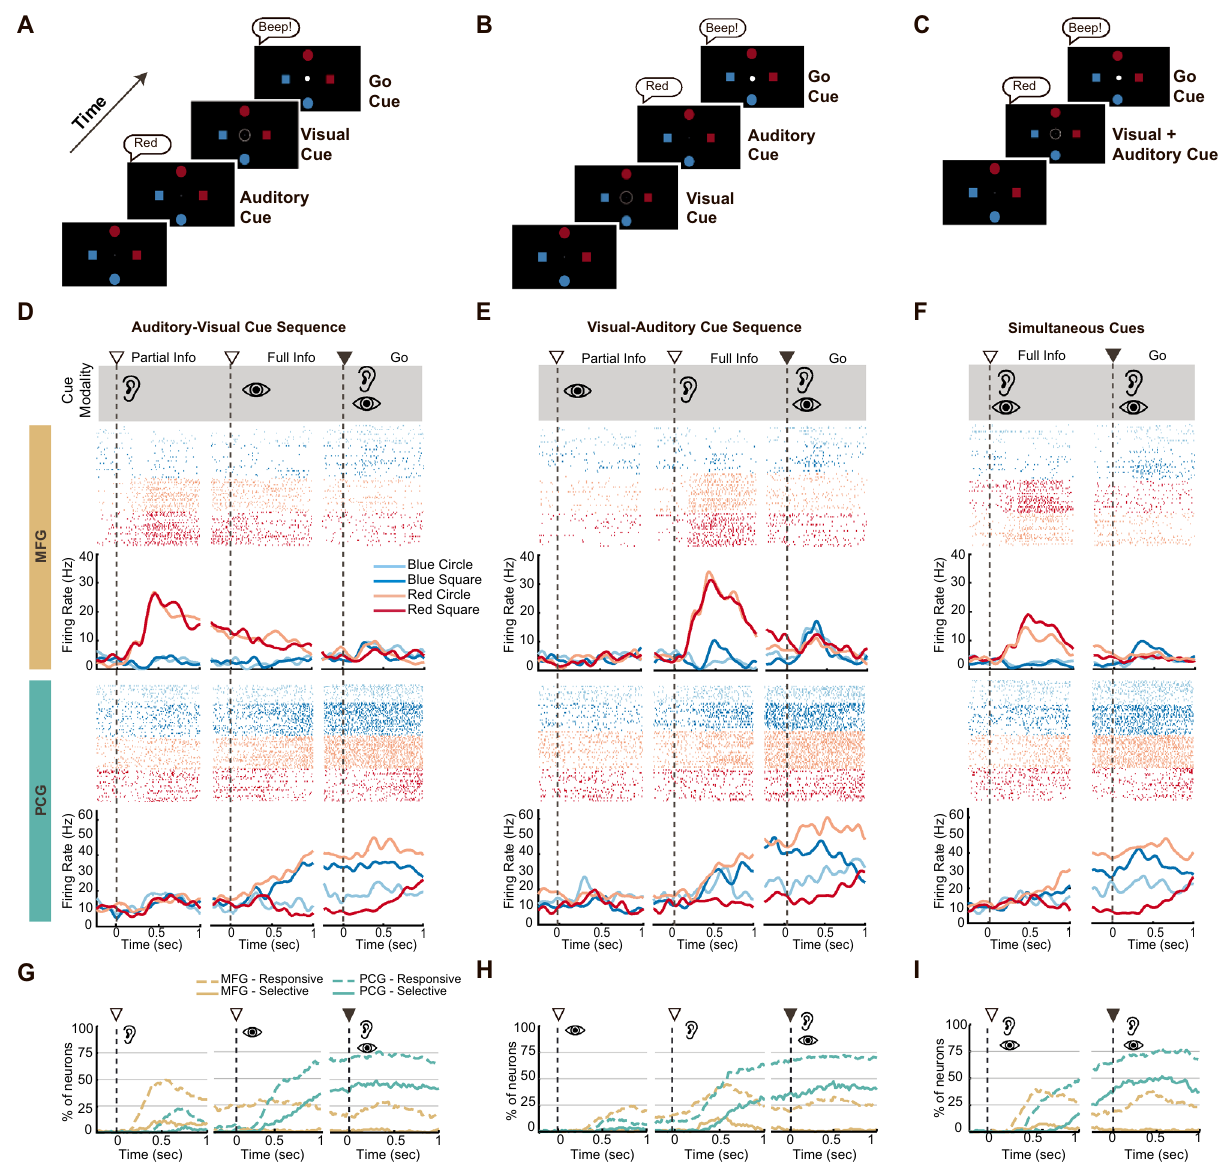
Figure 2. Single neuron responses to auditory and visual cues during three different variations of a Multi- modal center-out iBCI task. ( A – C ) Task sequences for three variants of a Multi-modal center-out task consisting of different cue presentation orders: auditory-visual (AV) task sequence ( A ), visual-auditory (VA) task sequence ( B ), and the simultaneous cue (A + V) presentation sequence ( C ). ( D – F ) Example raster-histograms for a single MFG neuron ( top row, yellow banner ) and PCG neuron ( bottom row, teal banner ) during the AV task sequence ( D ), the VA task sequence ( E ), and the A + V task sequence ( F ). Averaged firing rate traces for each target (smoothed with a 200 ms Gaussian kernel) are presented under each raster plot. White triangles ( ∇ ) represent the instructional cue onsets; black triangles represent the go cue onset; Ear symbol represents an auditory cue; eye symbol represents a visual cue (trial day 356, MFG channel 17, unit 1, PCG channel 12, unit 3). ( G – I ) Percentages of MFG ( yellow line s) and PCG neurons ( teal lines ) with responsive ( broken line ) and selective ( solid line ) firing patterns during the AV ( G ), the VA ( H ), and the A + V ( I ) task sequence. Neurons were classified as responsive if they displayed firing rates significantly different from baseline during task performance (significance level = 0.01; Kruskal–Wallis (KW) test), and selective if firing rates differed significantly across targets. This figure was compiled using MATLAB 2017b, MathWorks software and labeled using Adobe Illustrator CC